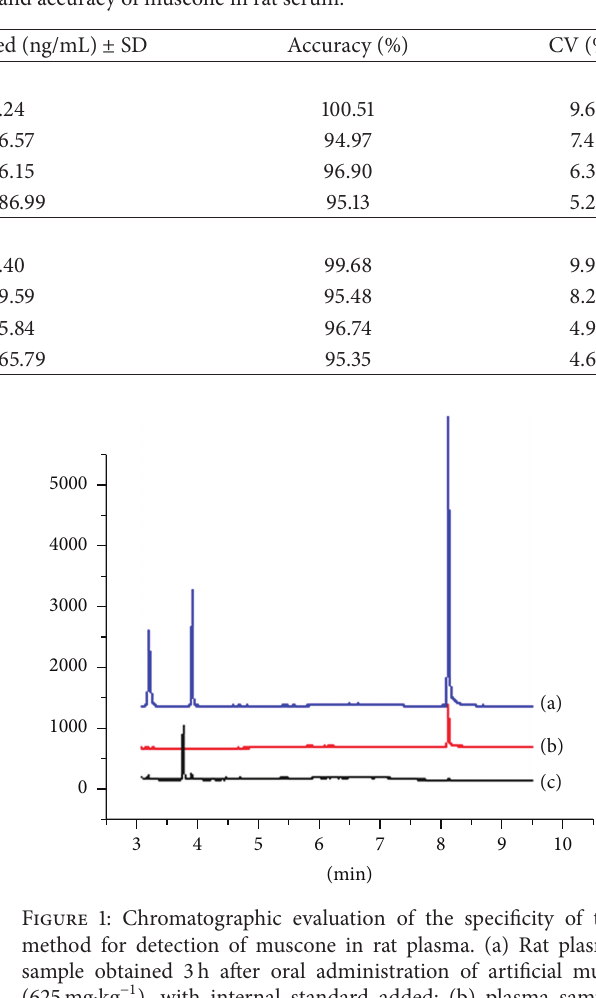
Table 2: Intra- and interday precision and accuracy of muscone in rat serum.